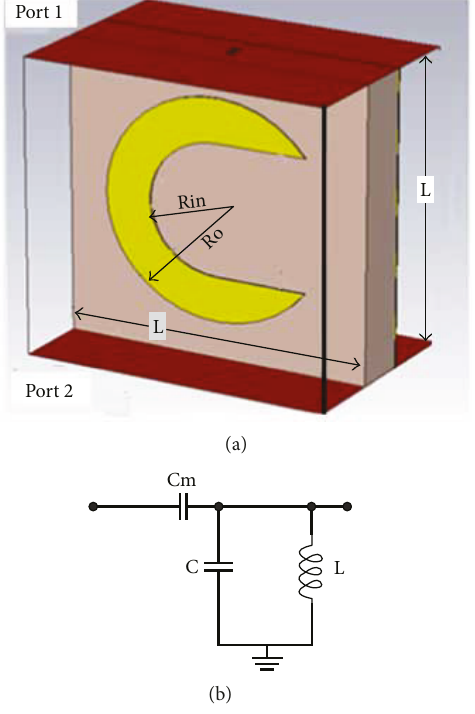
Figure 4: The unit cell of CSR structure. (a) 3D view of the unit cell. (b) The equivalent circuit of the